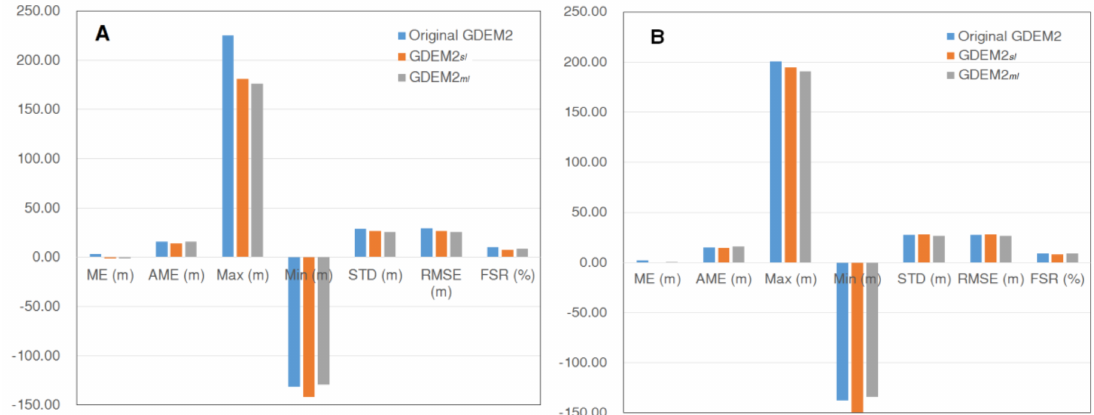
Figure 6. The statistical measures of the elevation errors for the original GDEM2 and calibrated GDEMs ( GDEM2 sl and GDEM2 ml ) for the calibration ( A ) and the effect of sampling ( B ).